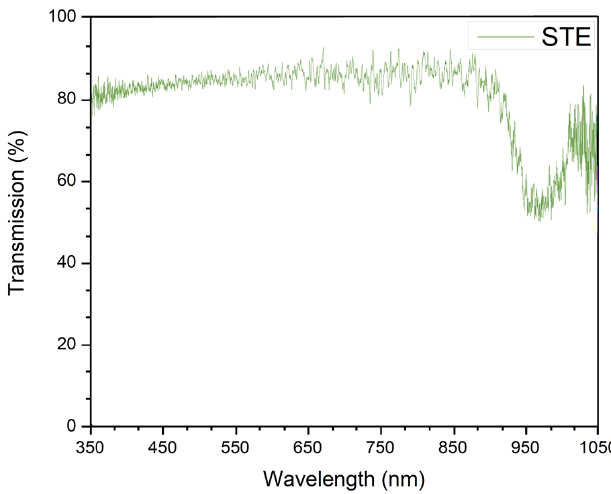
Figure 1. Absorption spectra of the STE buffer medium.